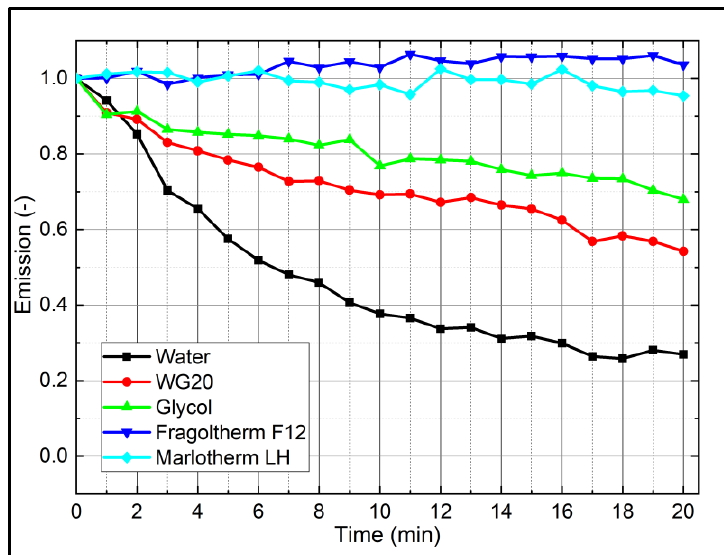
Figure 4. Photo-bleaching effect of the investigated liquid – tracer mixtures (9.38 mg/L), 293 K.